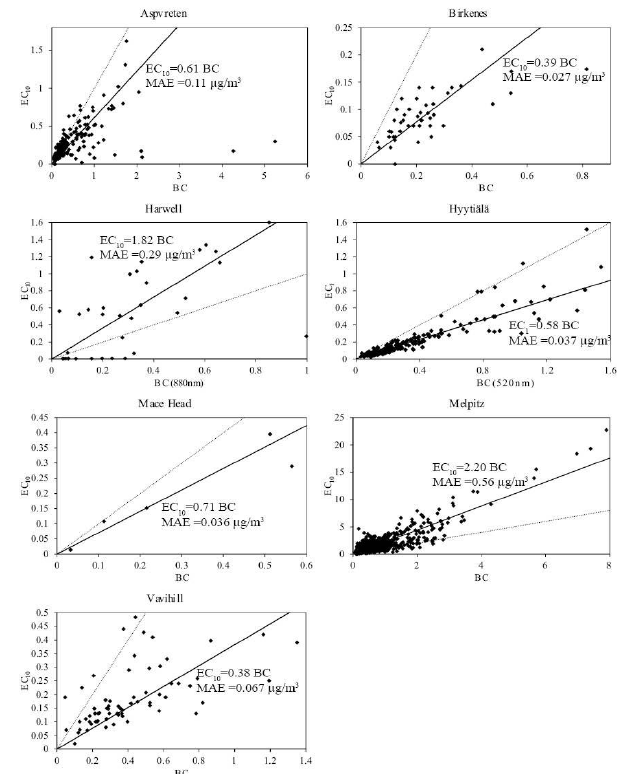
Fig. 2. Scatterplots of measured EC and BC showing data from pe- riods with overlapping thermal and optical measurements. The data shown in these plots were used to calculate the site-specific MAC e values (see Table 2) which are used to convert the optical absorption data to BC e concentrations. The solid line is the fit and the dotted line is the 1 : 1 line. Note that the x axis shows BC either provided directly by the Aethalometer or calculated from the absorption data using the assumed MAC value 10m 2 g − 1 . MAE is the mean abso- lute deviation (in EC) from the fitted line. Unit: µgm − 3